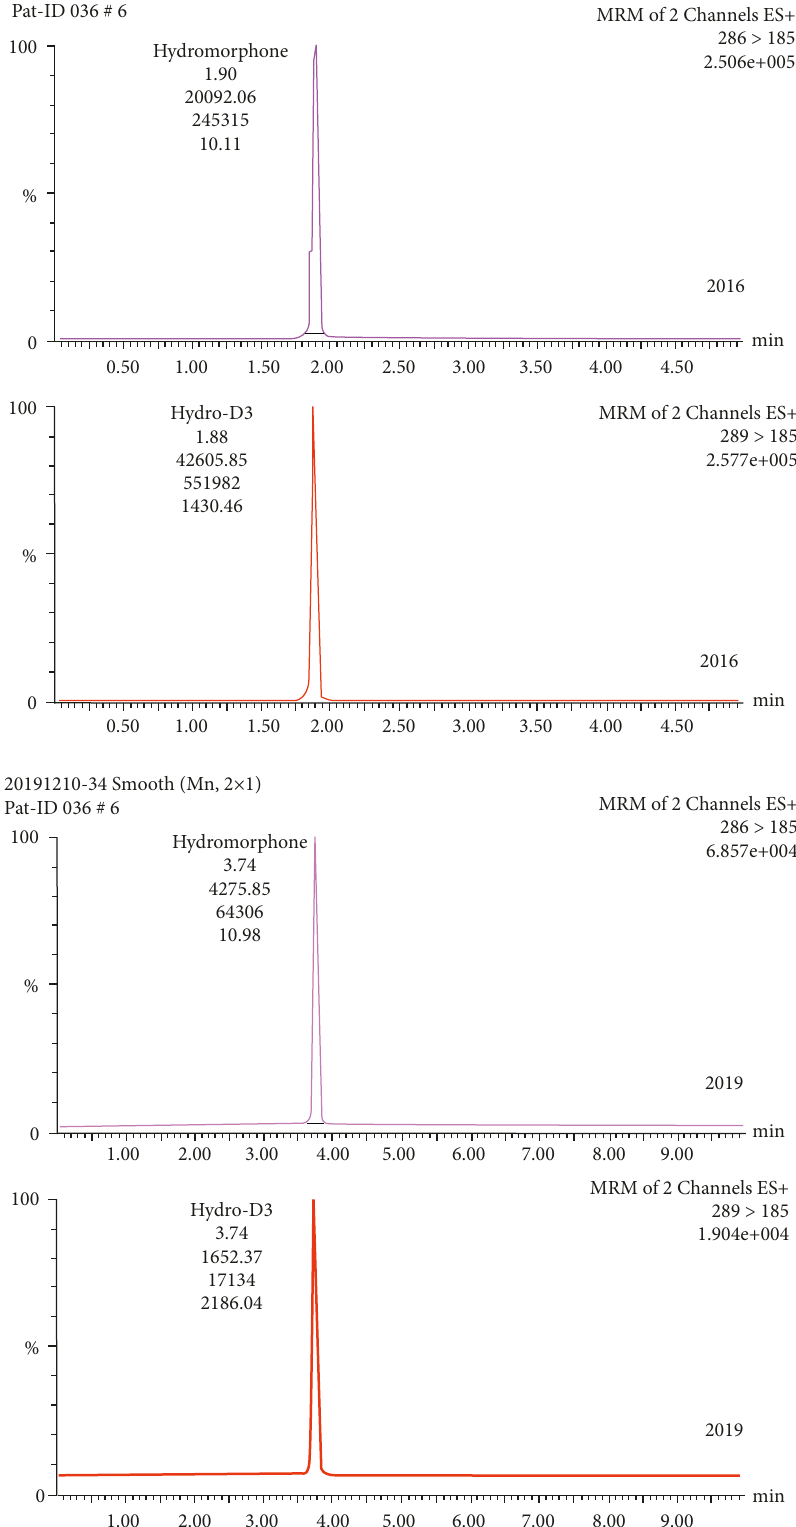
Figure 5: Chromatograms of a patient sample measured in 2016 (two upper panels) and 2019 (two lower panels). The signal of hydromorphone is shown in the top panel each and the signal of internal standard hydromorphone-D3 is shown in the bottom panel each,